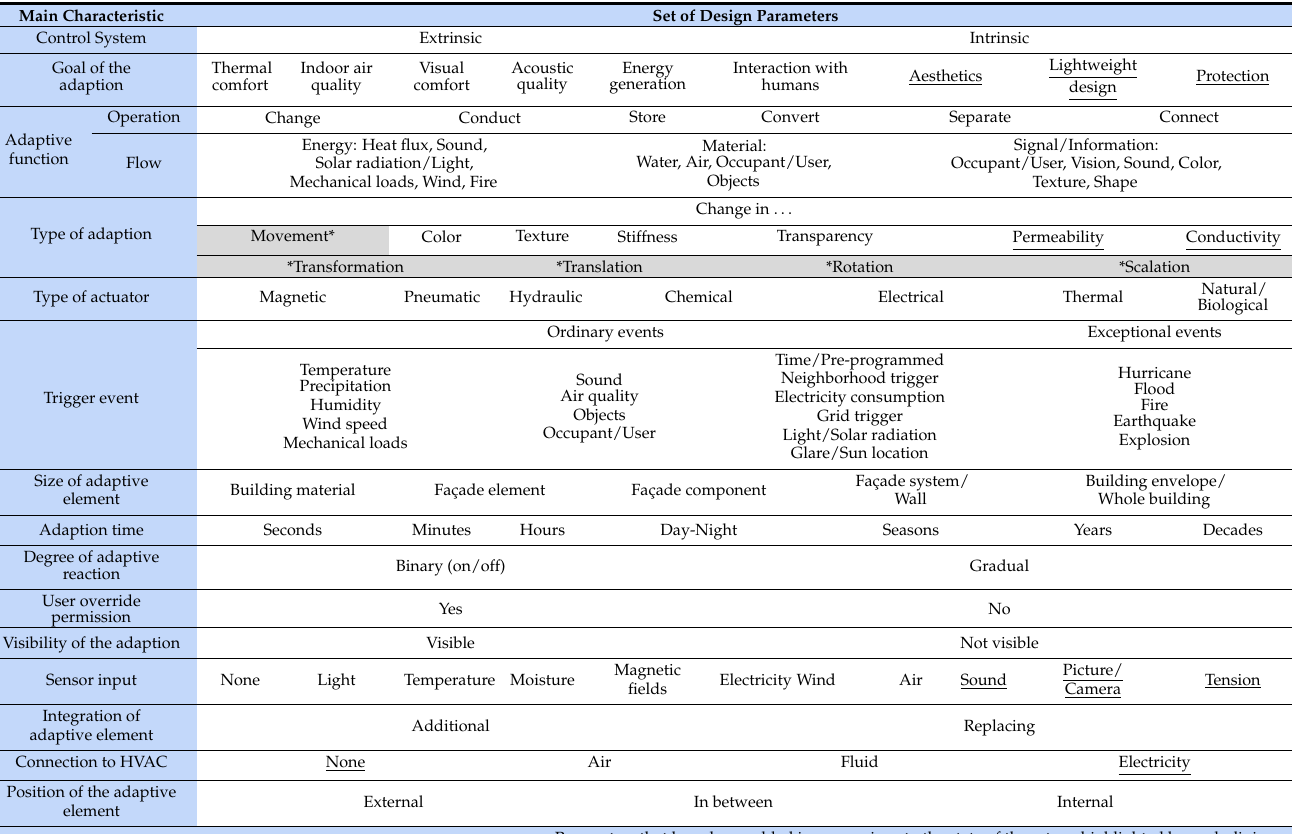
Table 2. The solution set of AF design parameters refined from the initial draft in [24], * cells highlighted in grey present a sub-set of “movement” as a type of